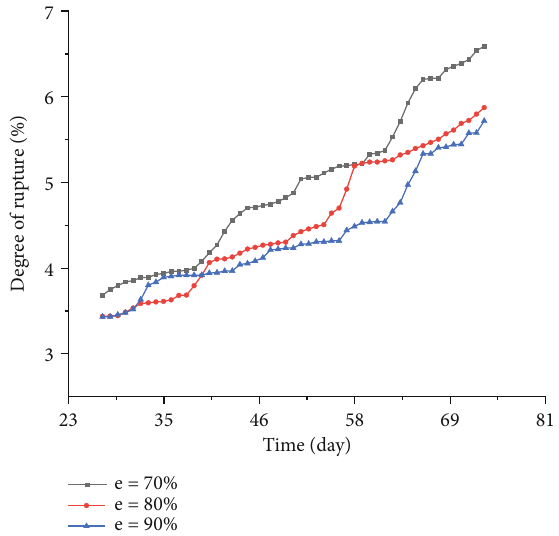
Figure 14: Long-term rupture degree considering di ff erent fi lling